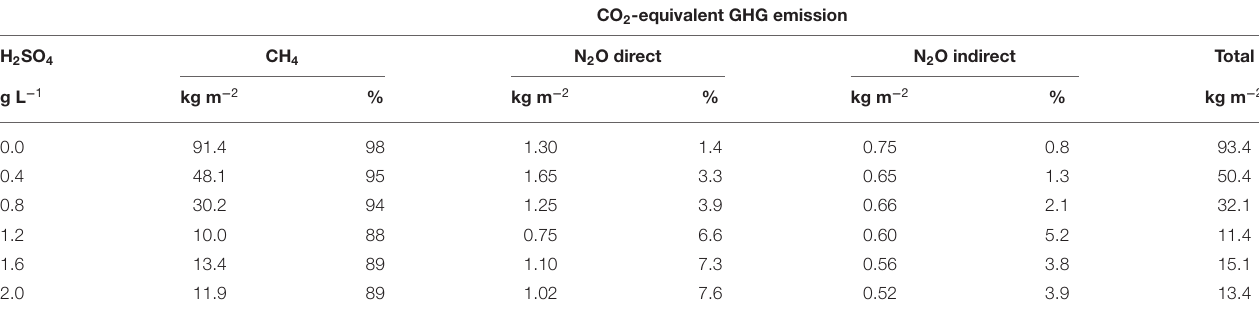
TABLE 3 | Total greenhouse gas (GHG; kg CO 2 -eq m − 2 ) emitted from stored liquid dairy slurry per rate of H 2 SO 4 (g L − 1 slurry) over the 114-d storage period (May 25–September 15,